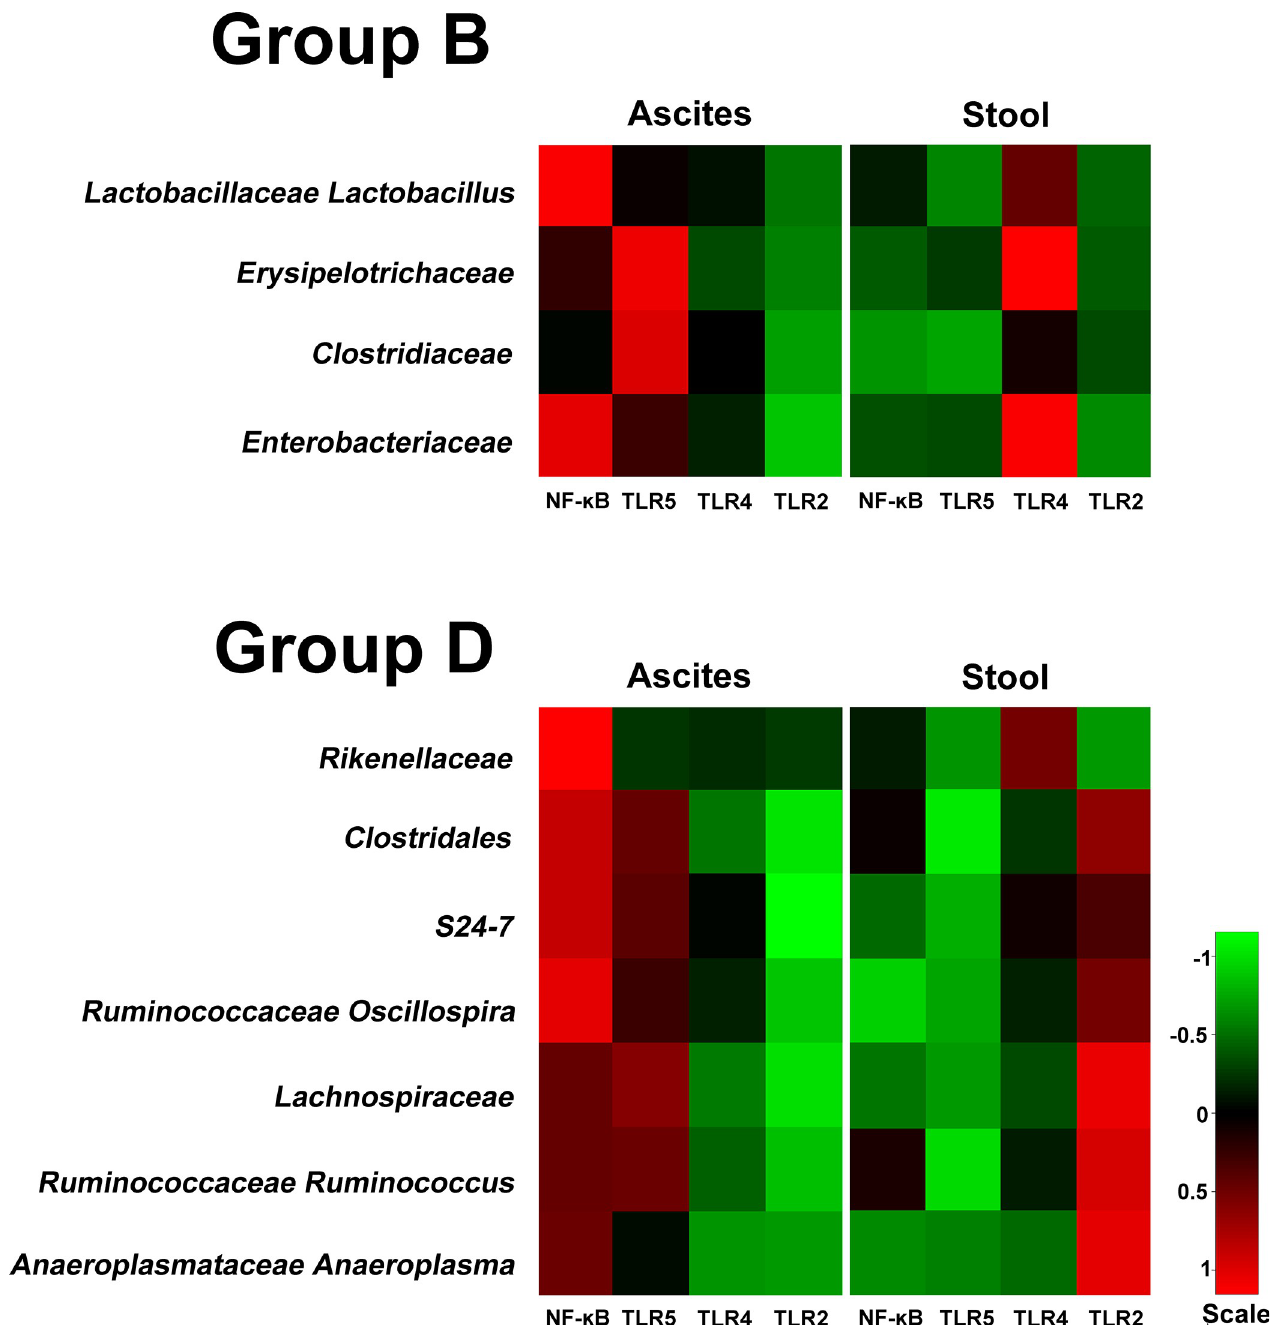
Fig 4. Time-dependent expression bacterial 16s rRNA from the metagenomic analysis of the isolated ascites, blood, and stool samples of C57BL/6 mice 0, 4, 8, and 16 h after CLP experiment. � indicated a significant different OUT number than those in the same sample (ascites, blood, or stool) from the sham- control C57BL/6 mice, which were indicated as 0